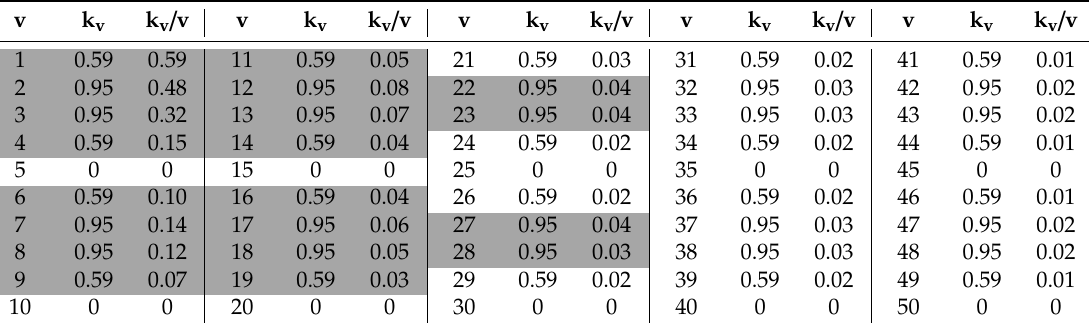
Table A4. Harmonic winding factors of the five-phase